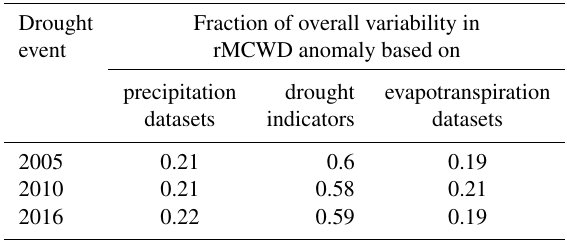
Table 2. Fraction of overall variability in rMCWD anomaly based on precipitation datasets, drought indicators and evapotranspiration